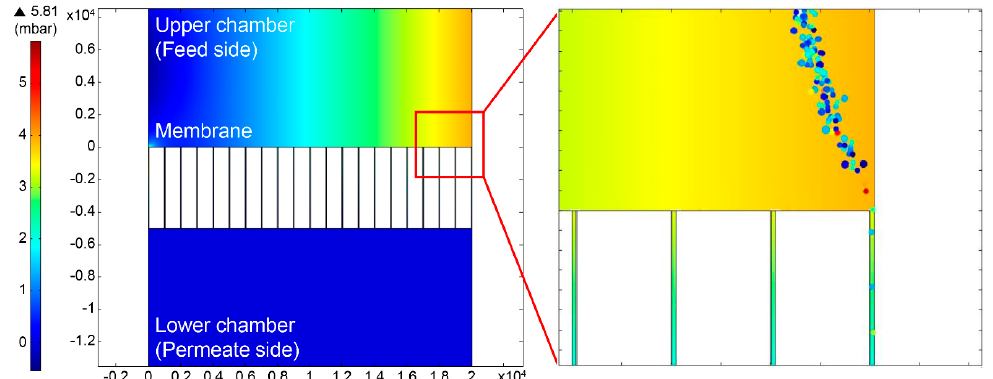
Figure 4. Pressure ( left ) and particle ( right ) trajectories simulated using computational fluid dynamics (CFD) simulations in the cross-flow filtration system.